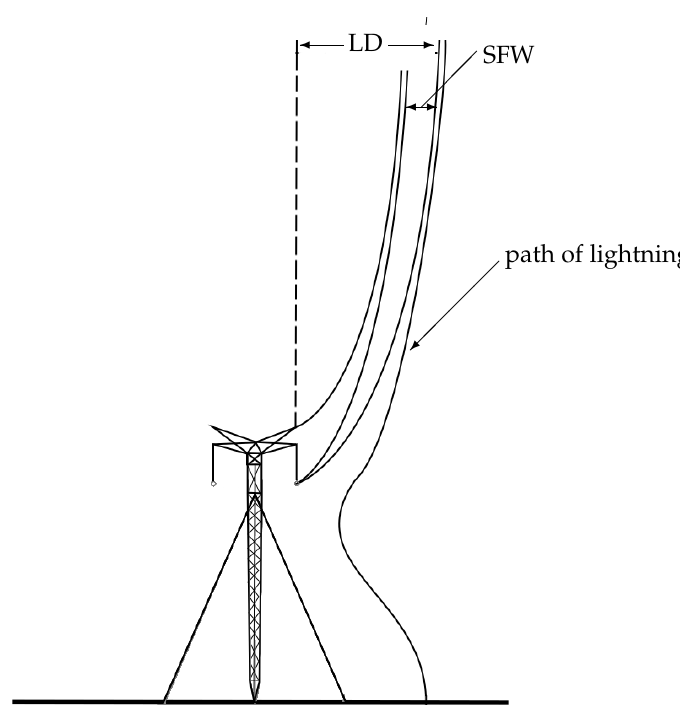
Figure 1. Diagram that illustrates lateral distance (LD) and shielding failure